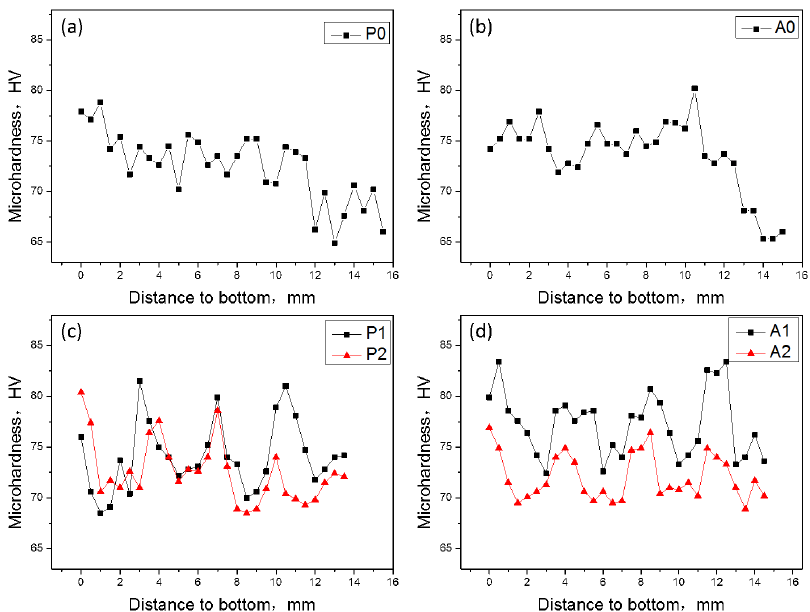
Figure 12. The micro hardness distributions of the WAAM 2319 aluminum alloys. ( a ) sample P0 = thin wall with CMT ‐ P; ( b ) sample A0 = thin wall with CMT ‐ ADV; ( c ) sample P1 (lower heat input) & sample P2 = block with CMT ‐ P; ( d ) sample A1 (lower heat input) & sample A2 = block with